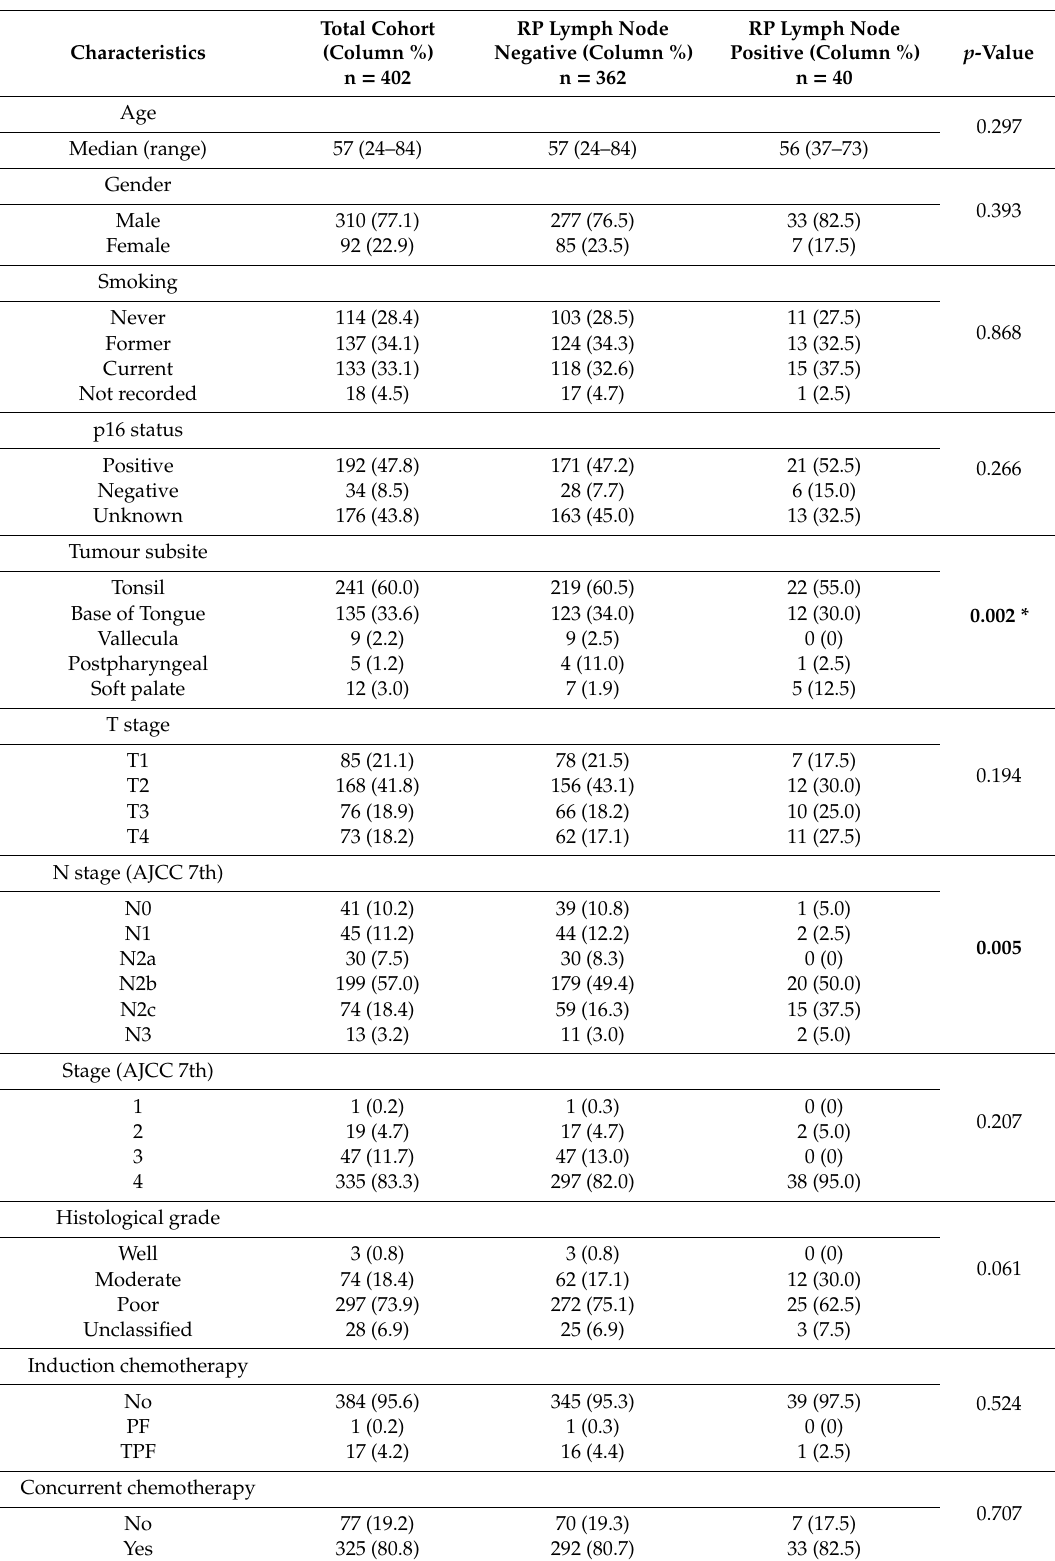
Table 1. Patient, disease and treatment